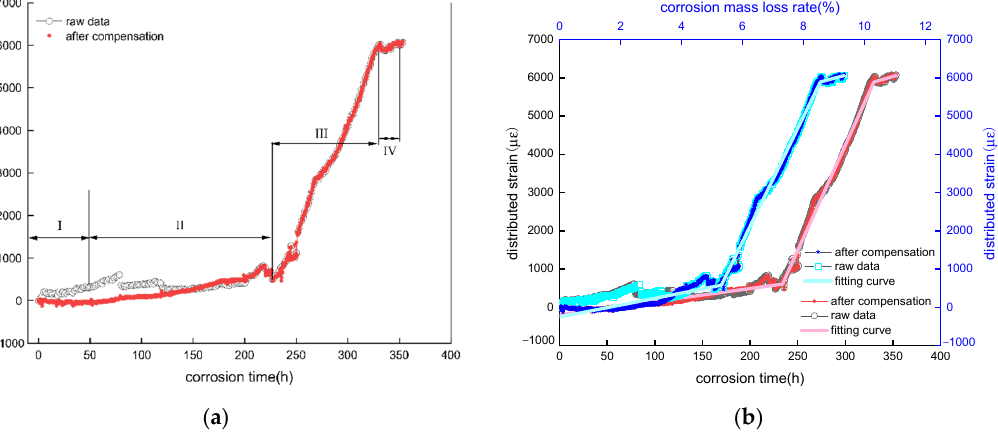
Figure 13. Fiber strain—time curve of mortar layer of 2-300# specimen. ( a ) raw data from reinforced layer distributed sensor; ( b ) fitting curve after temperature Table 4. Test parameters for significance of fitting curve (blue curve) of Figure 12b.